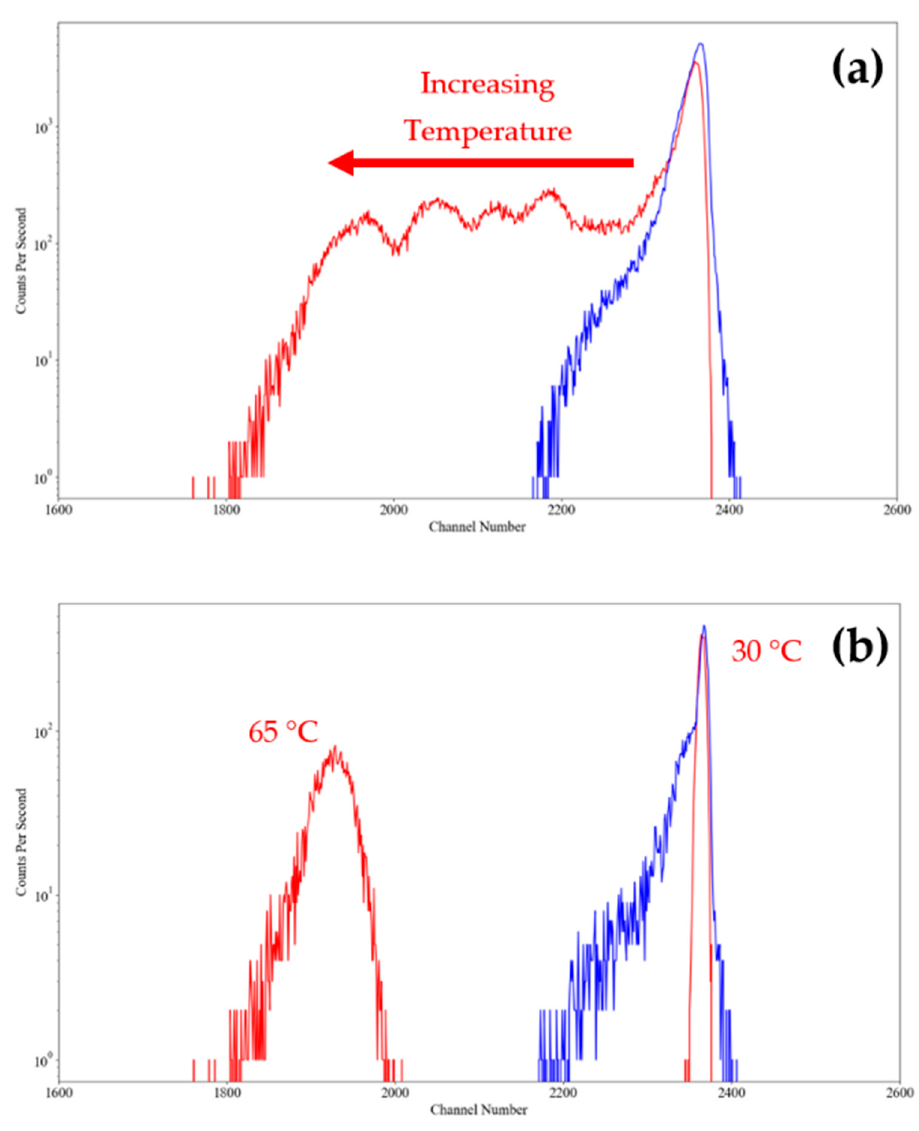
Figure 15. A log graph ( a ) plotting cumlative spectra taken over the full heating experiment. A log graph ( b ) of individual spectra taken at 30 °C and 65 °C, respectively, for both compensated (blue trace) and non-compensated (red trace) systems. Only channels 1600 to 2600 have been displayed for purposes of clarity.